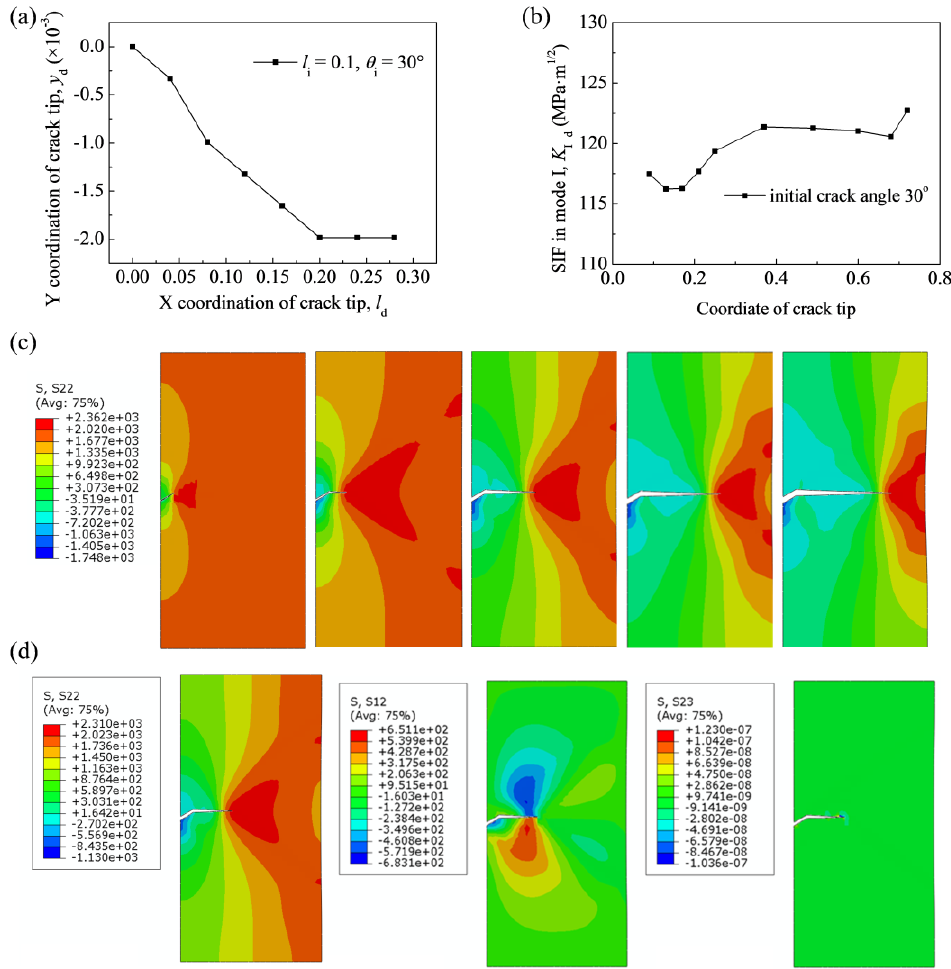
Figure 6. ( a ) Crack propagation path; ( b ) K Id in the propagation process; ( c ) S 22 stress contours in the crack propagation process ( d ) Comparison of stress contours in three orientations when the crack propagates to 0.4 for an in-plane model with an initial angle 30° and initial length 0.1.